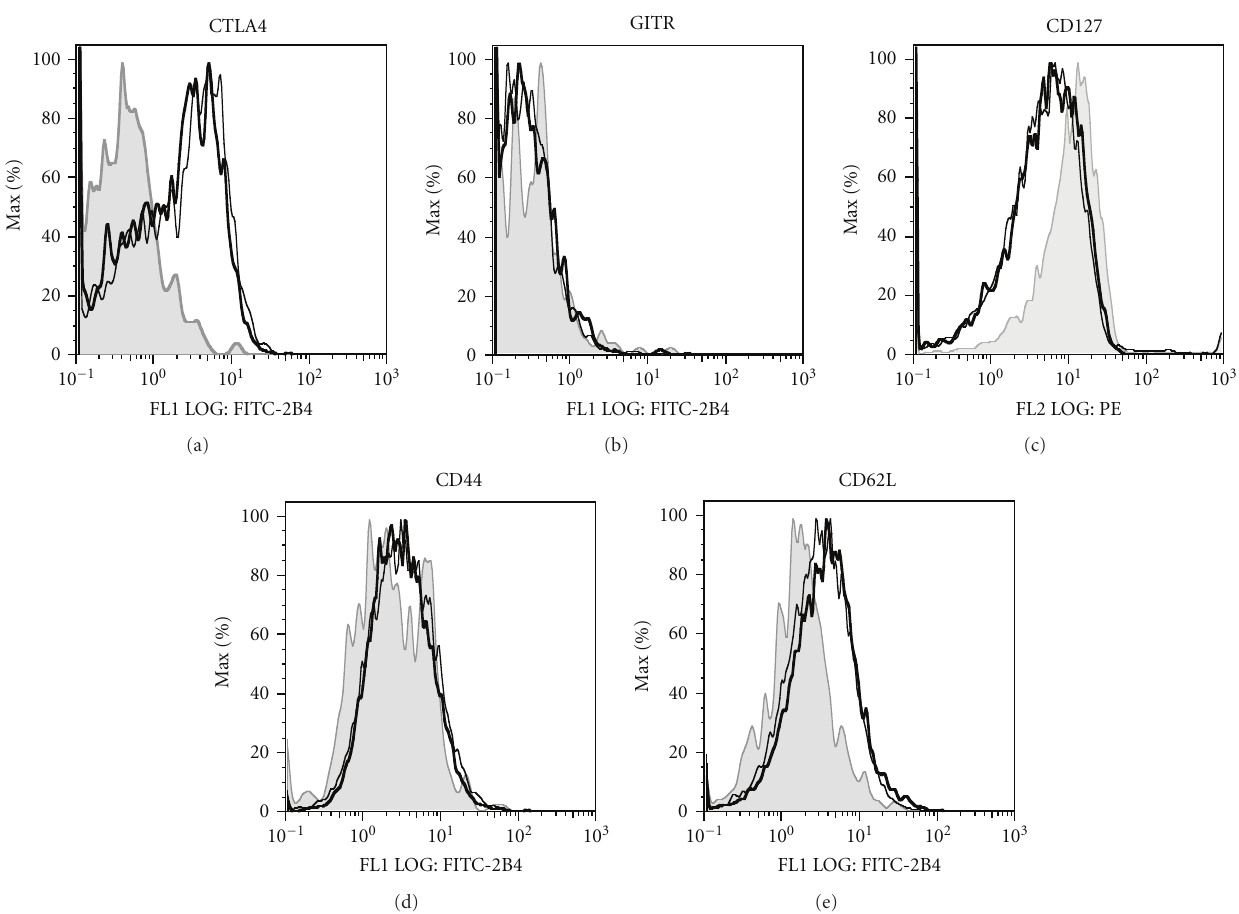
Figure 1: Flow cytometry analysis of e ff ector/memory T-cell markers on α -MSH-induced Treg cells. Isolated draining lymph node CD4 T cells from immunized mice were stimulated and treated with α -MSH (30pg/mL). After 72 hours of incubation, all the cells were stained for CD25. The cells were also stained for CTLA4, GITR, CD127, CD44, or CD62L. The costained cells were analyzed by flow cytometry. Presented results are a representative of two experiments showing the histogram expression of CTLA4, GITR, CD127, CD44, or CD62L on the gated CD25 + T-cell population. The gray shaded histograms are resting T cells; the thin lines are e ff ector T cells; the thick lines are the α -MSH-induced Treg cells. There was no significant di ff erence in the expression of CTLA4, GITR, CD127, CD44, or CD62L on the α -MSH-induced Treg cells compared to the stimulated e ff ector T